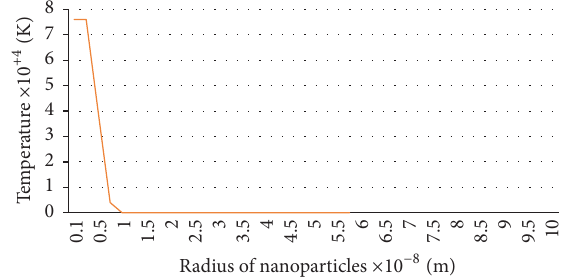
Figure 3: The relation between the temperature and radius for silicon nanoparticles prepared by laser of 10ns for 740 mJ.